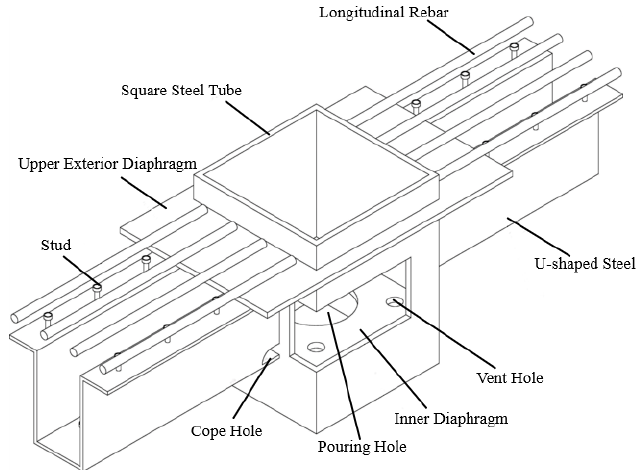
Figure 4. RP connection.